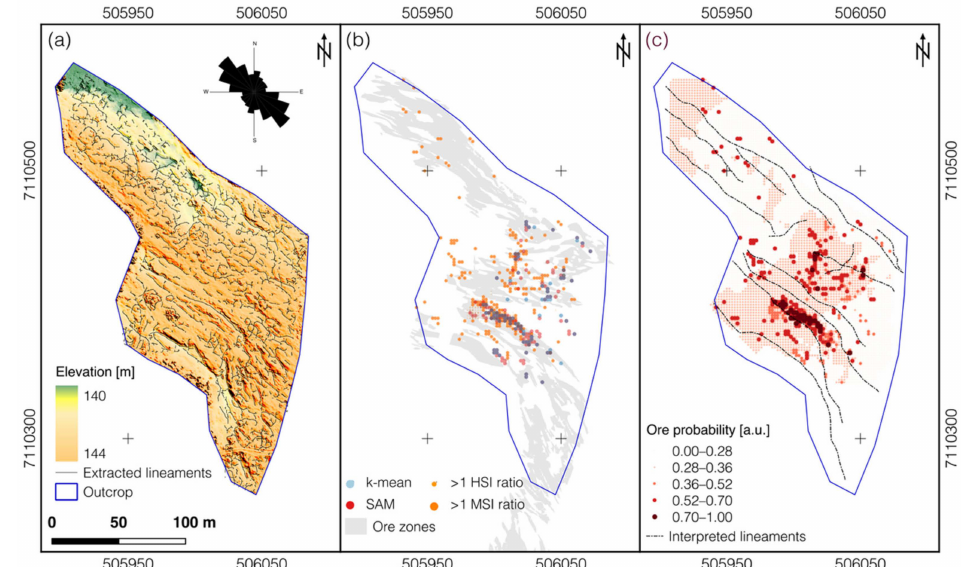
Figure 16. ( a ) SfM-MVS DSM clipped to the outcrop surface. Plotted on top are automatically extracted lineament features. Rose plot as line direction histogram shows NW–SE trending of extracted lineaments (n = 12,311). ( b ) Combined UAS-borne MSI and HSI classification (semi-transparent colors) and iron ratio results, resampled to the 2 m grid size of the 15 m multicopter TMI grid. ( c ) Integrated results of spectral and magnetic UAS-survey, giving a probability for ore occurrences, where higher values indicate alignment of detected features (a.u. = arbitrary unit). Further directional context is given by the interpreted surface lineaments, based on the automatically extracted